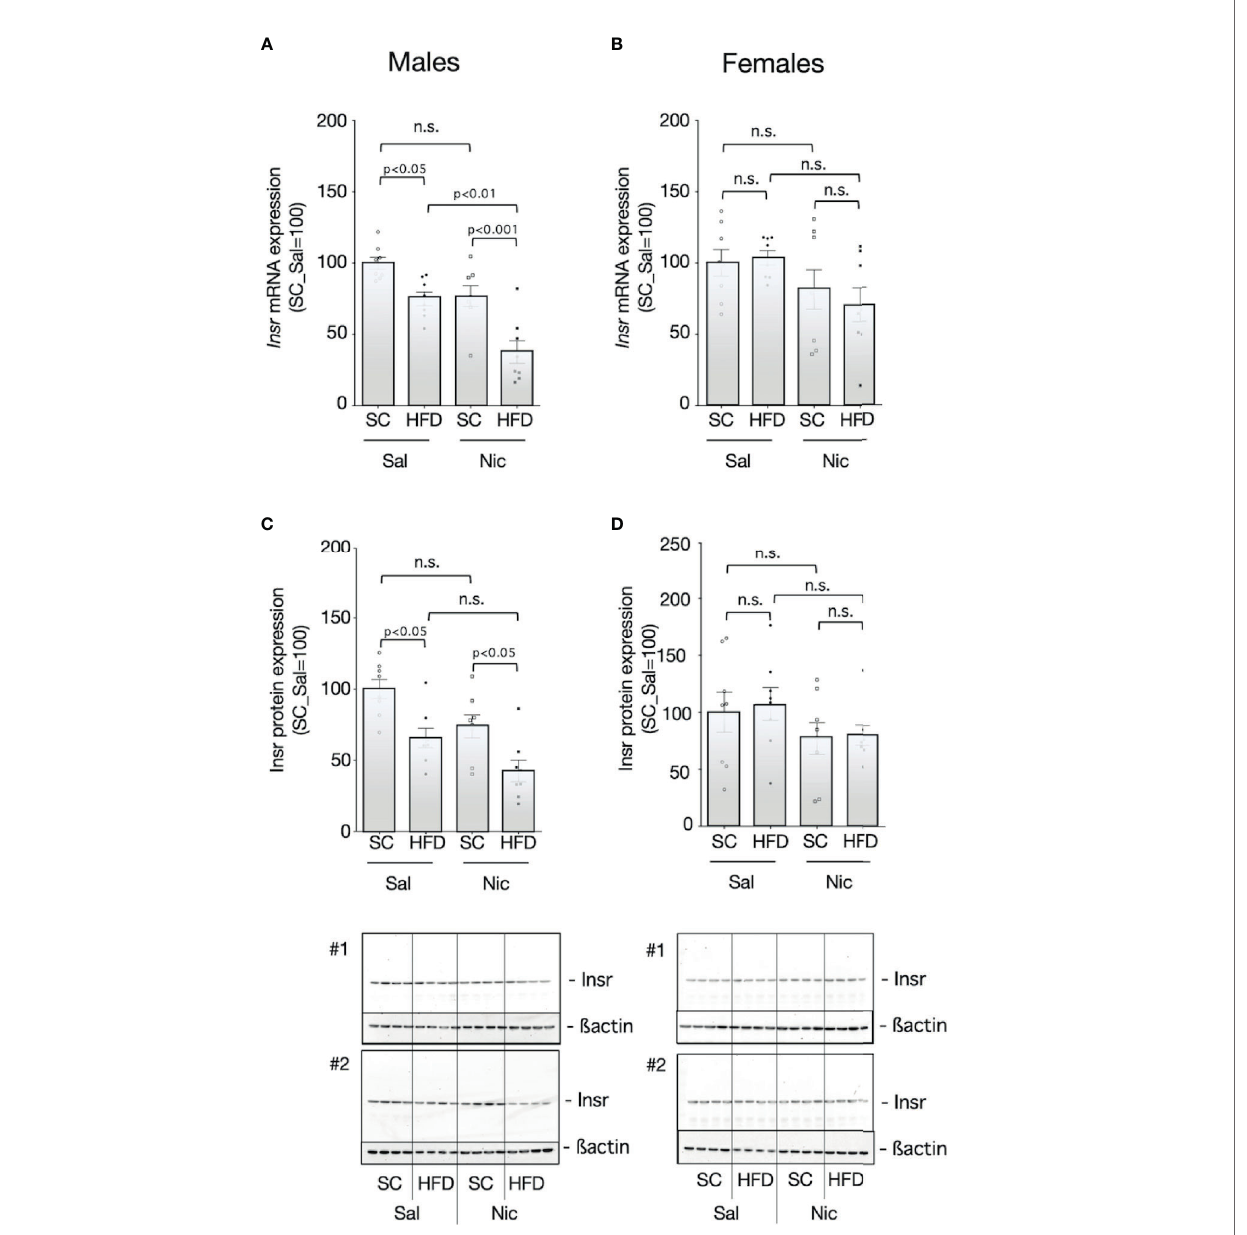
FIGURE 5 | Expression of insulin receptor (Insr) in the liver. Insr mRNA expression levels ( A for males and B for females) and Insr protein expression levels ( C for males and D for females) in the liver of standard chow-fed (SC) offspring or high fat diet (HFD)-exposed offspring from nicotine-administered dams (NIC) or saline- treated dams (Sal) were quanti fi ed. The mRNA expression levels were normalized to Gapdh levels and then to that in Sal, which was de fi ned as 100%. The protein expression levels were normalized to that of ß-actin and then to that in Sal, which was de fi ned as 100%. Values are presented as means ± SEM (n=8). Statistical analysis was performed using one-way ANOVA followed by Tukey ’ s post hoc test for multiple comparisons. n.s., not signi fi cant (p ≥